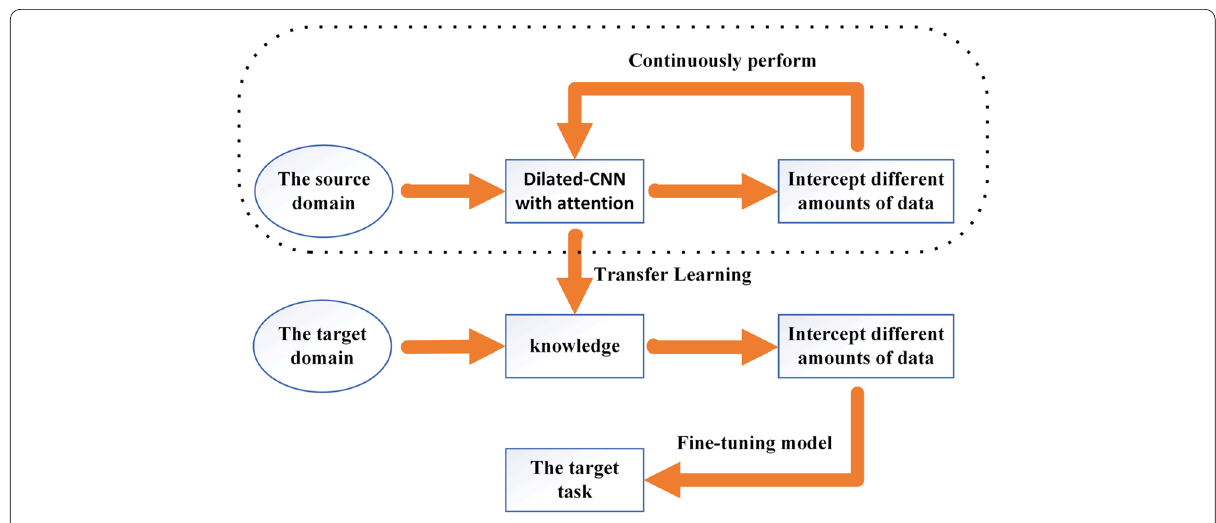
Figure 5 Schematic diagram of transfer learning